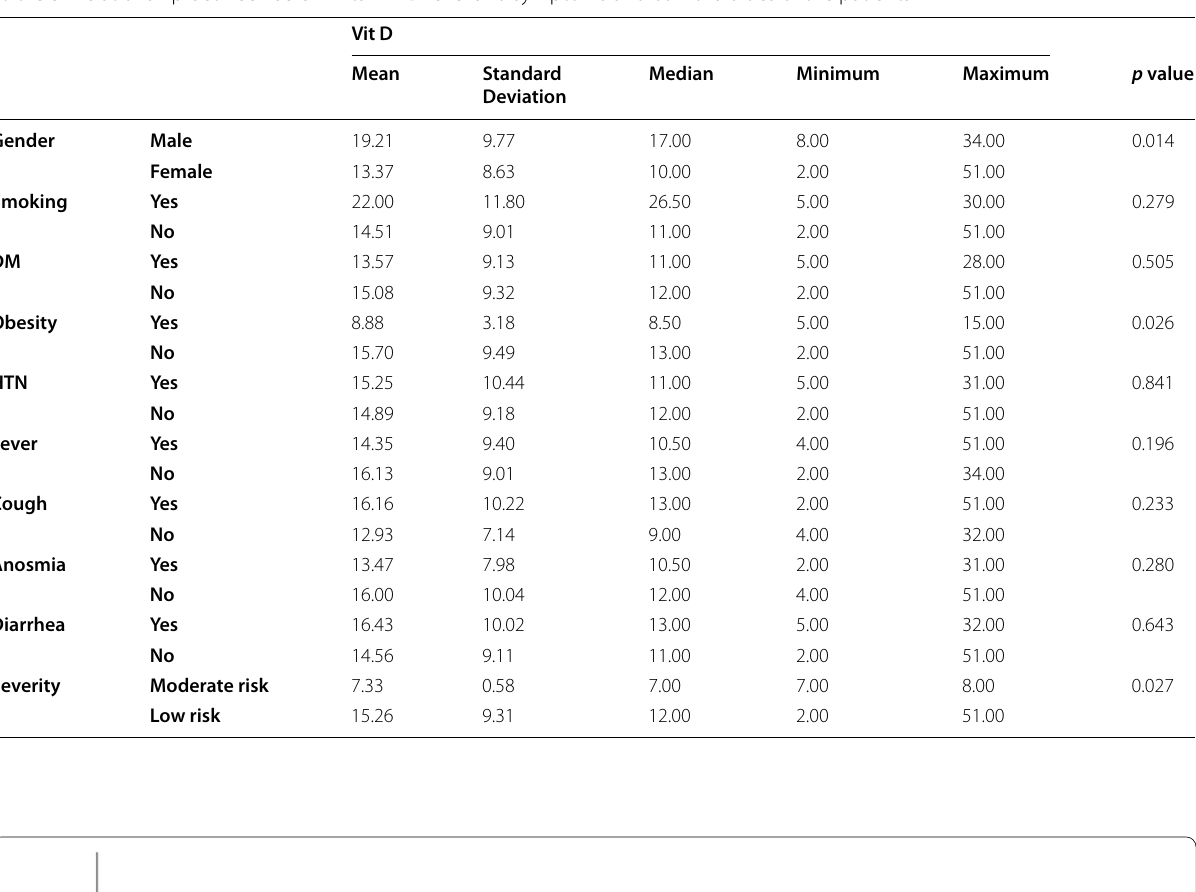
Table 3 Relationship between serum vitamin D level and symptoms and comorbidities of the patients